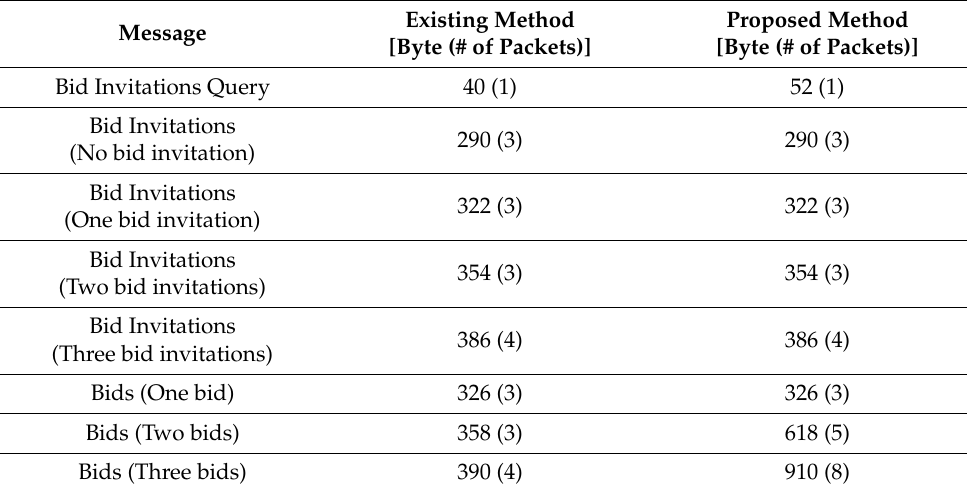
Table 1. Size of messages in bytes and number of packets.